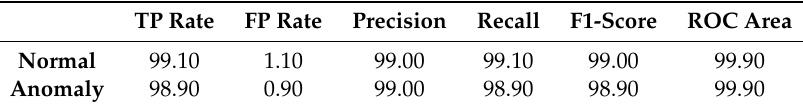
Table 28. Classification report for Adaboost J48.